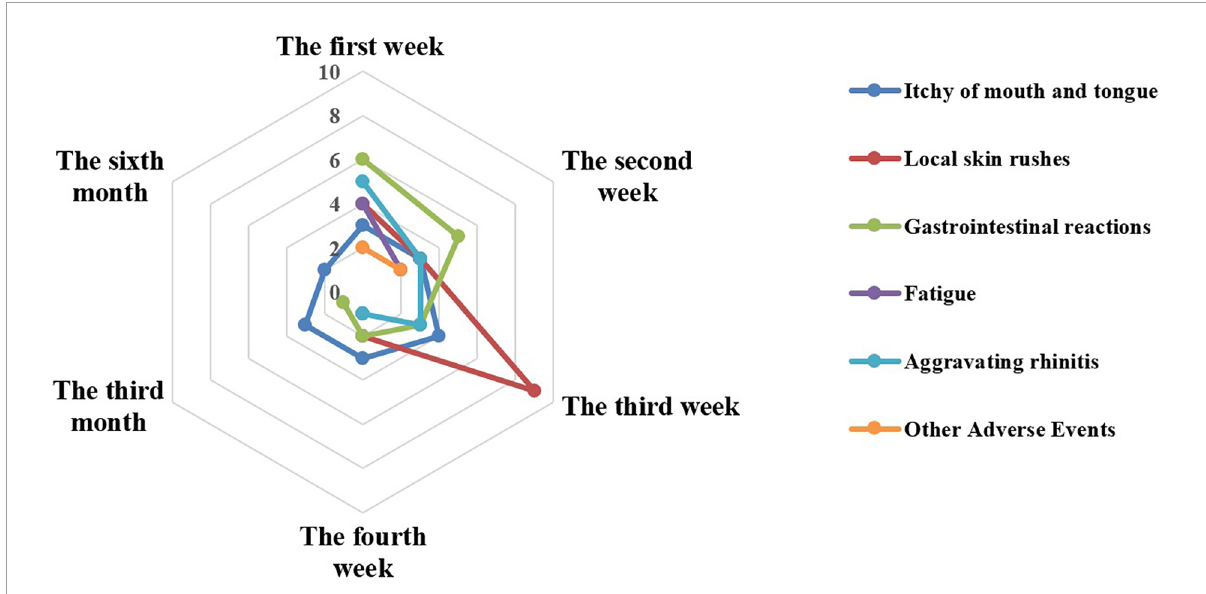
FIGURE2 The number of adverse events at different